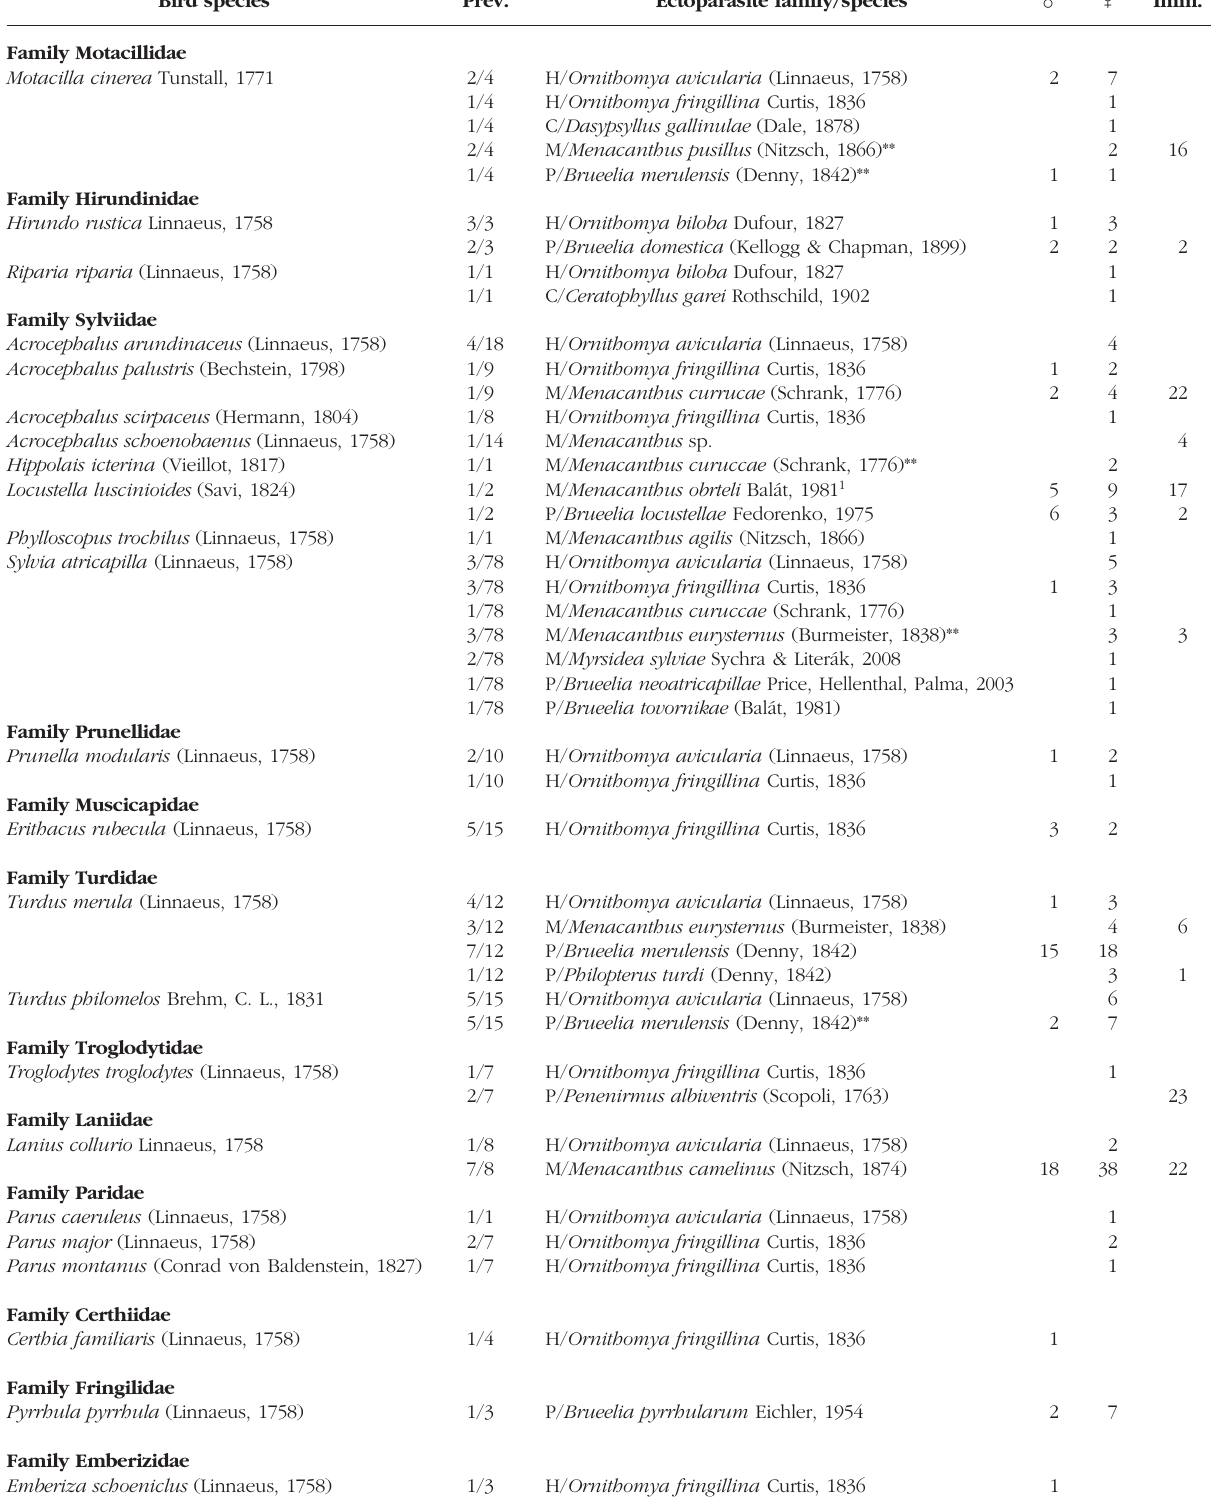
Table I. – List of hosts and their insect